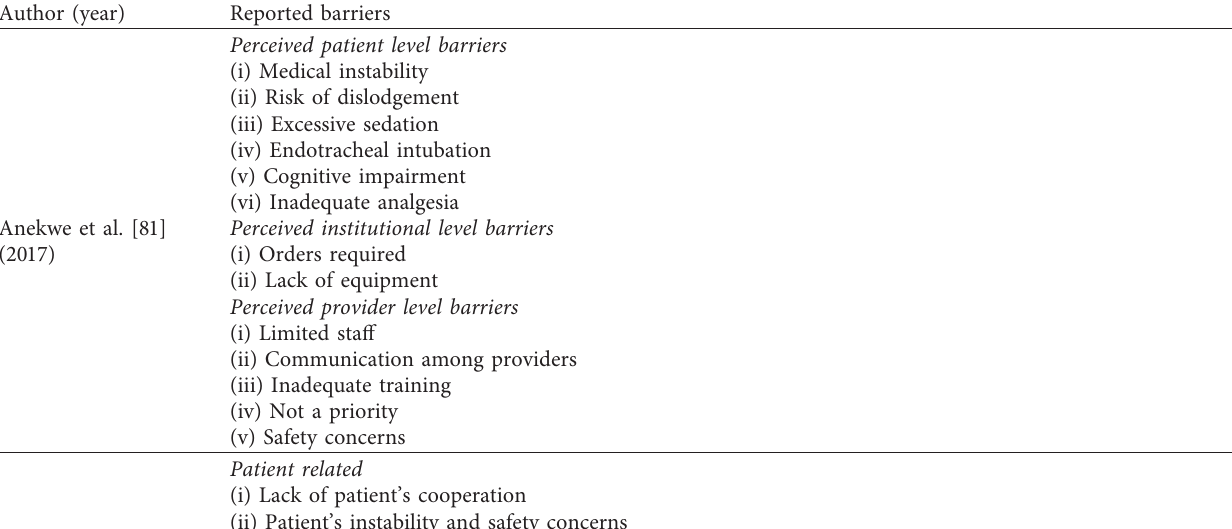
Table 10: Barriers to early